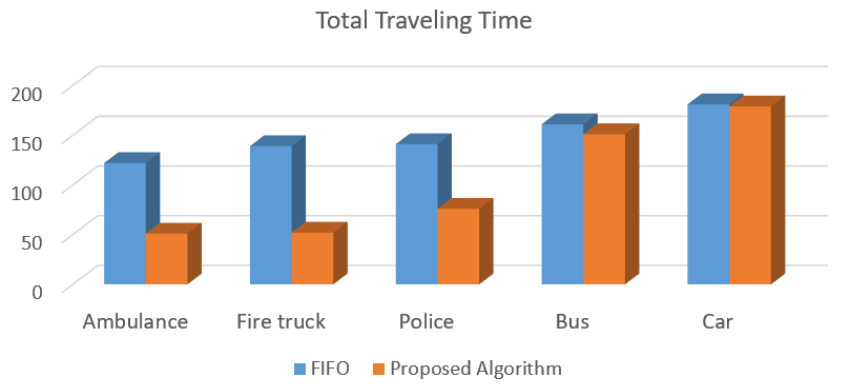
Figure 10. Total traveling time reached by the proposed traffic control algorithm and FIFO for each type of